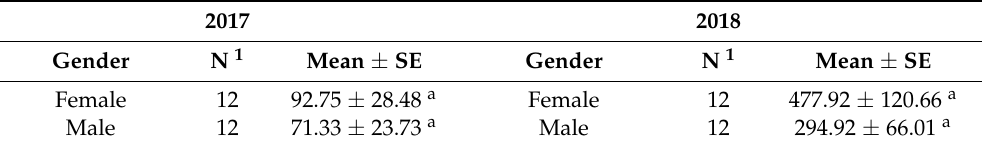
Table 5. Average numbers of adult males and females caught on blueberries using Scentry ® traps during the sampling periods in 2017 and 2018.